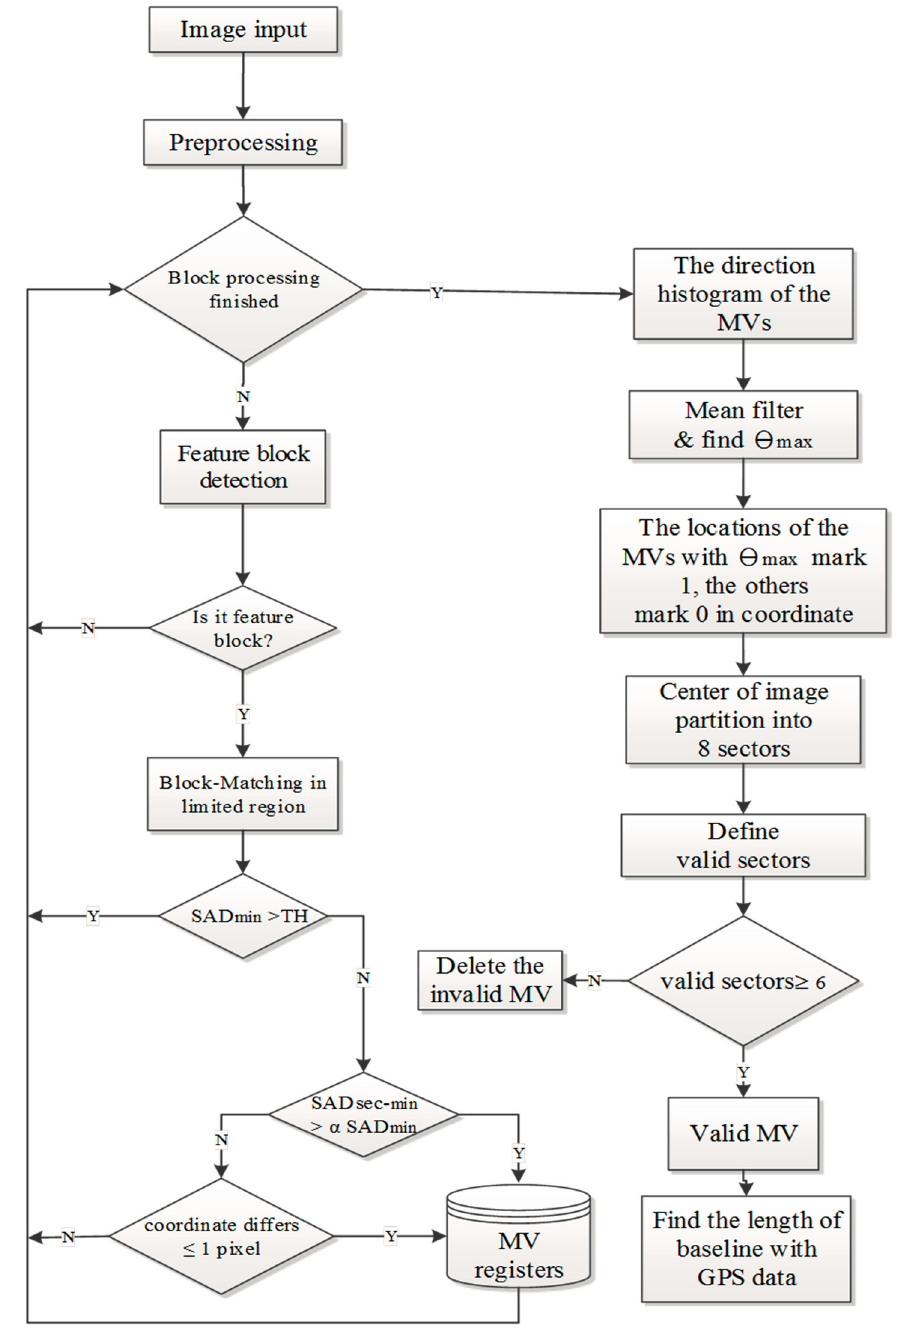
Figure 3. Flying direction detection